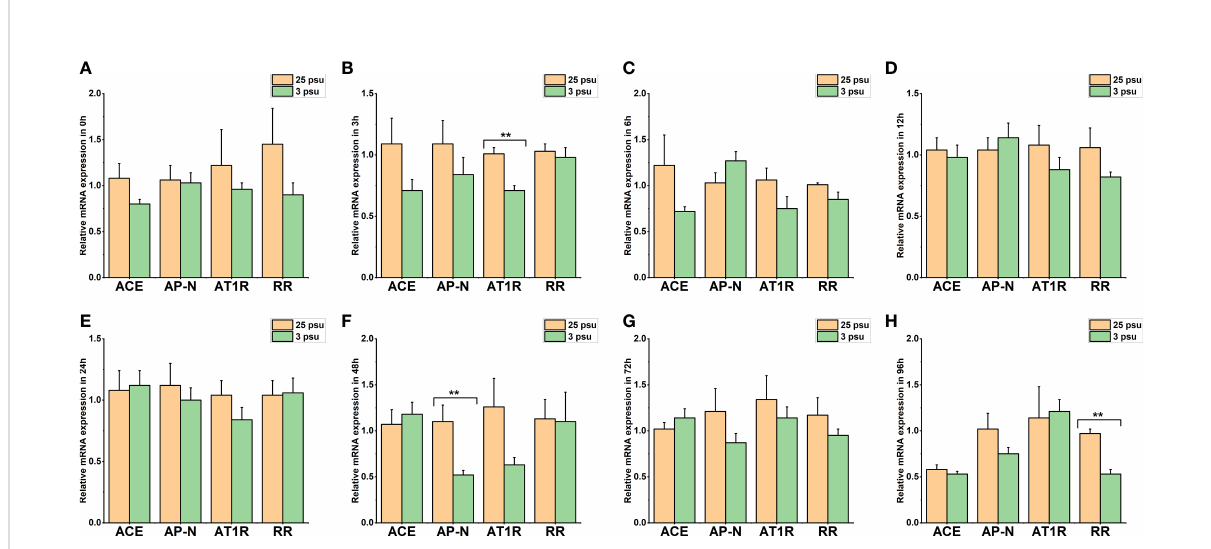
FIGURE 8 The expression levels of LV-ACE , LV-APN , LV-AT 1 R , and LV-RR in the hepatopancreas at 0 h (A) , 3 h (B) , 6 h (C) , 12 h (D) , 24 h (E) , 48 h (F) , 72 h (G) , and 96 h (H) of short-term low salinity stress. Signi fi cant differences are indicated with ** marks ( P < 0.05). Values are the mean ( ± SD). (N =